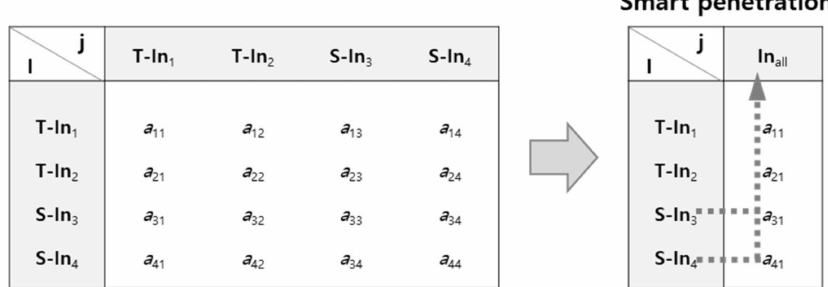
Figure 4. Example of the calculation of the smart